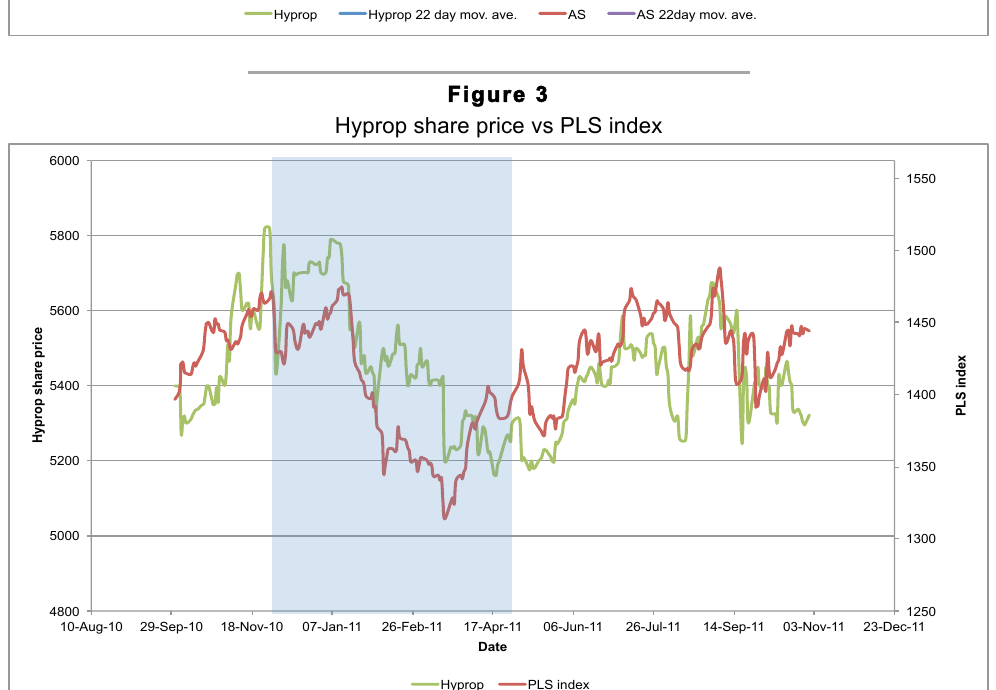
Hyprop share price vs PLS